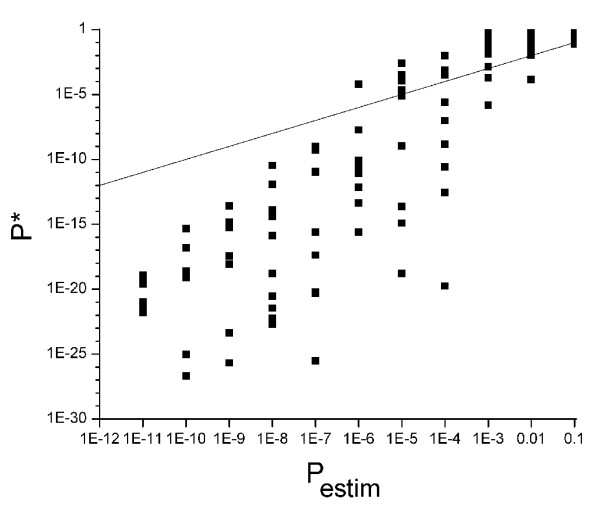
Upper estimates of P-value for comparison between two alignment columns: random simulation tests for consistency with null model. Using a random emission vector, a pair of columns was randomly generated that corresponded to a specified value of the PEAC estimate of (Pestim). P-value for the generation of such a pair by the used emission vector (P*) was plotted against Pestim. See text for details.